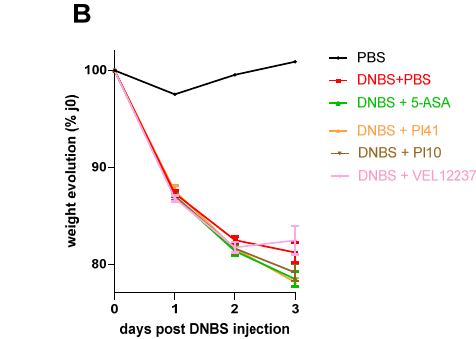
Figure 8. ( A ) Kaplan–Meier survival graph of the DNBS-induced colitis model. Number of dead mice post-DNBS injection: DNBS + PBS: 1/24 (4%), DNBS + 5-ASA: 4/24 (17%), DNBS + PI41: 2/16 (13%), DNBS + PI10: 2/16 (13%), DNVS + VEL12237: 5/16 (31%). No significant difference was observed in the survival curves (Mantel–Cox log-rank test p = 0.22). ( B ) Evolution of weight after DNBS